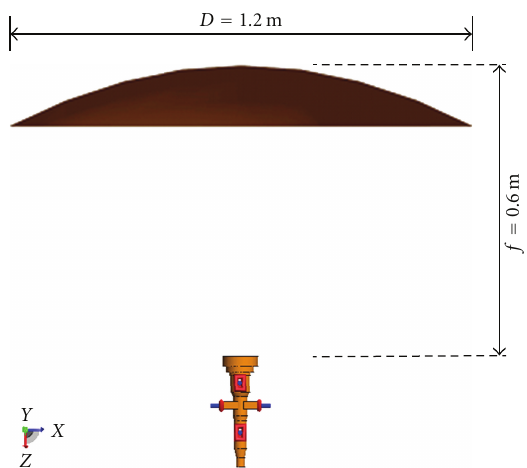
Figure 6: Feedhorn with a parabolic reflector antenna in symmetric configuration.